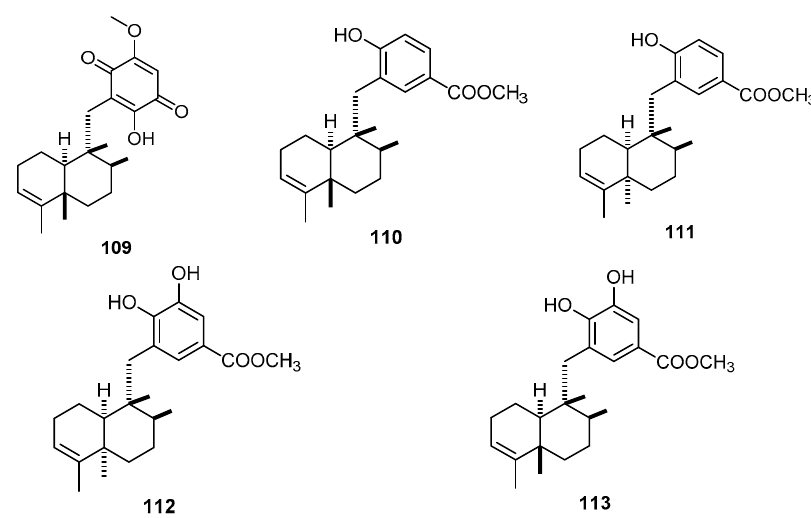
Figure 26. Chemical structures of isospongiaquinone ( 109 ), hyrtiophenol ( 110 ), 5-epihyrtiophenol ( 111 ), 18-hydroxy-5-epihyrtiophenol ( 112 ) and 18-hydroxyhyrtiophenol ( 113 ).